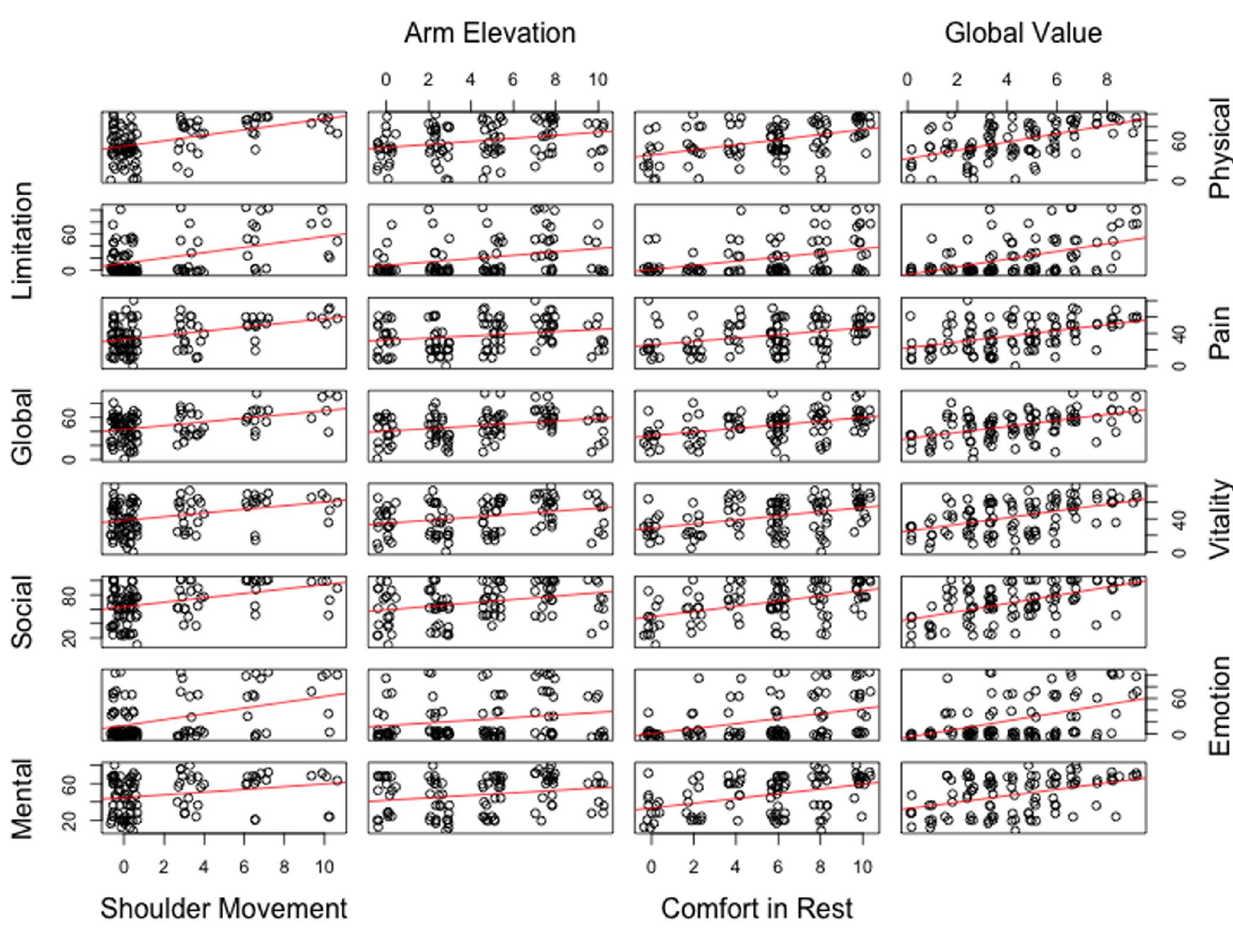
Figure 2. Correlation of Simple Shoulder Test Brazilian-Portuguese Version to SF-36.